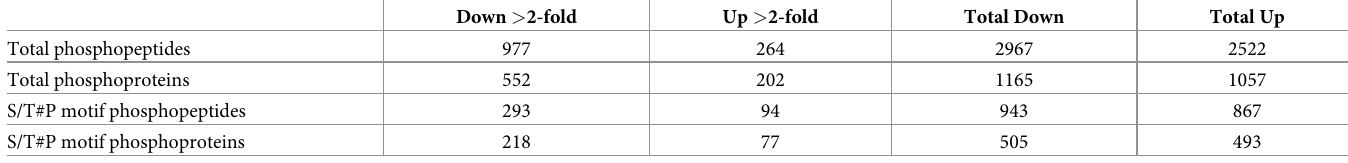
Table 1. Summary of phosphopeptides and phosphoproteins detected by motif. Analysis limited to those peptides to which P-values of < 0.05 were assigned in the comparison of ssn3 AS to the wild type (WT). Down indicates phosphopeptides lower in ssn3 AS treated with 3-MB-PP1 compared to WT treated with 3-MB-PP1; up indi- cates phosphopeptides that were more abundant in the ssn3 AS strain treated with 3-MB-PP1 compared to WT treated with 3-MB-PP1. The total refers to the number of peptides or proteins that are significantly different regardless of fold-difference. “#” indicates the detected phosphorylation on a serine or threonine, S/T, in a -1 position relative to a proline, S/T#P